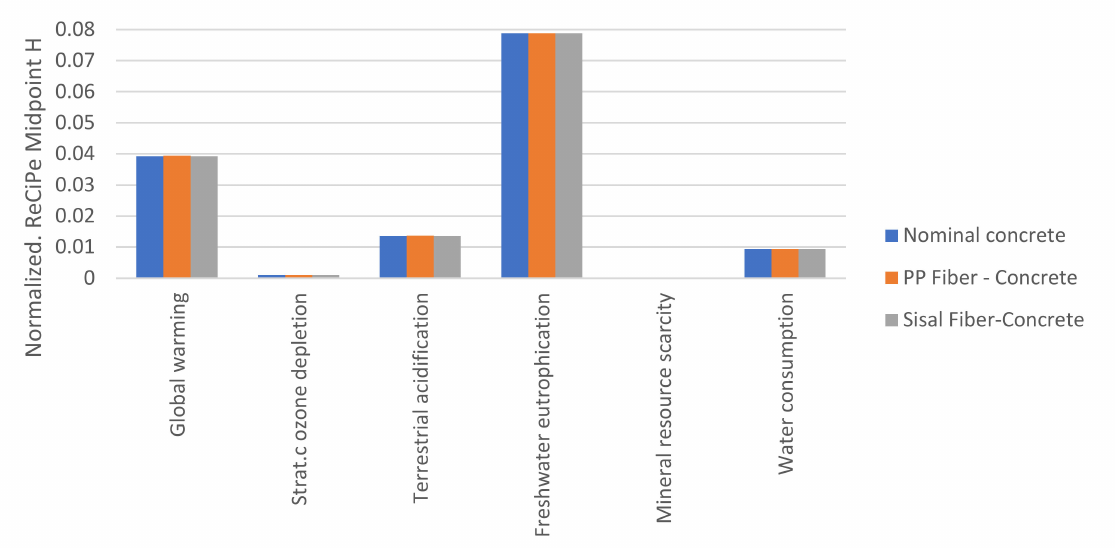
Figure 10. Normalized values for 1 m 3 of the concrete